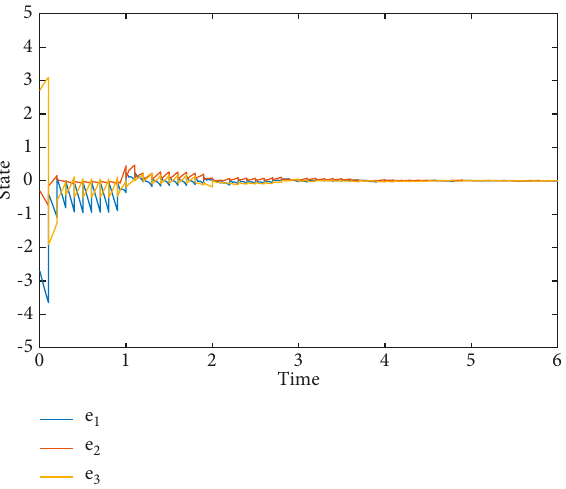
Figure 2: The trajectory of an error NN (26) with control